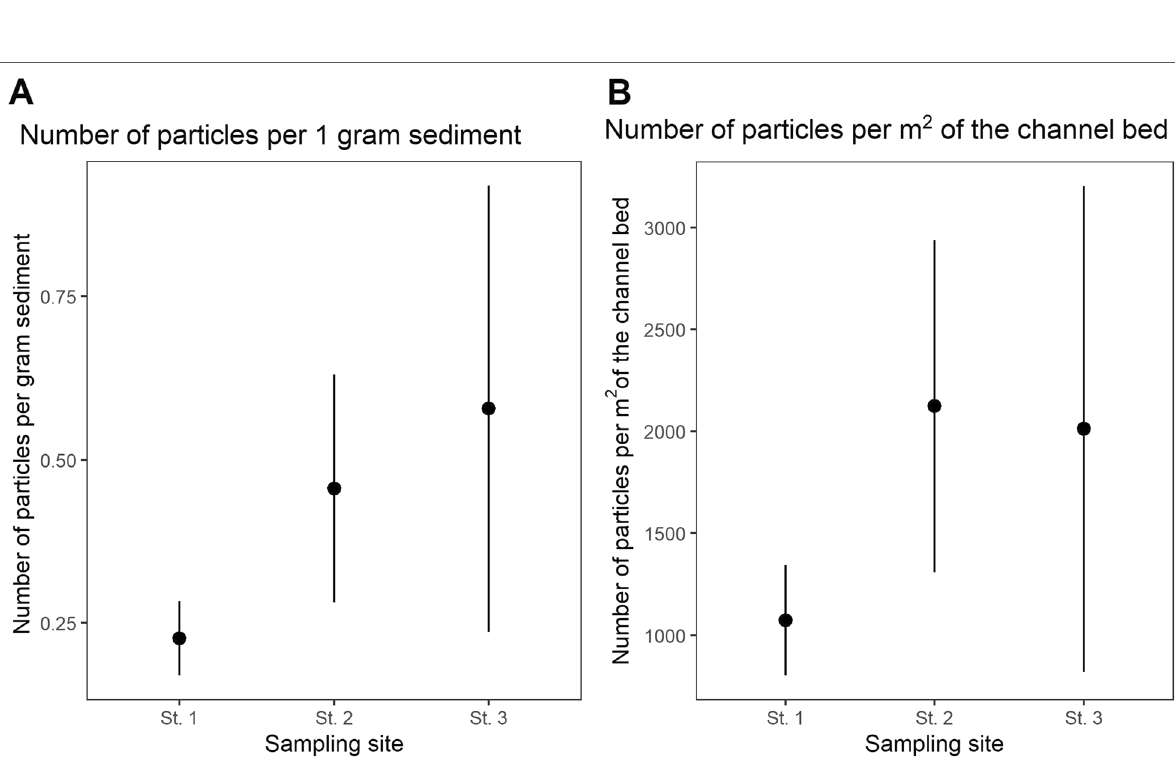
Fig. 4 Average concentrations of microplastic when reported A per g. dry weight and B per m 2 . Error bars show